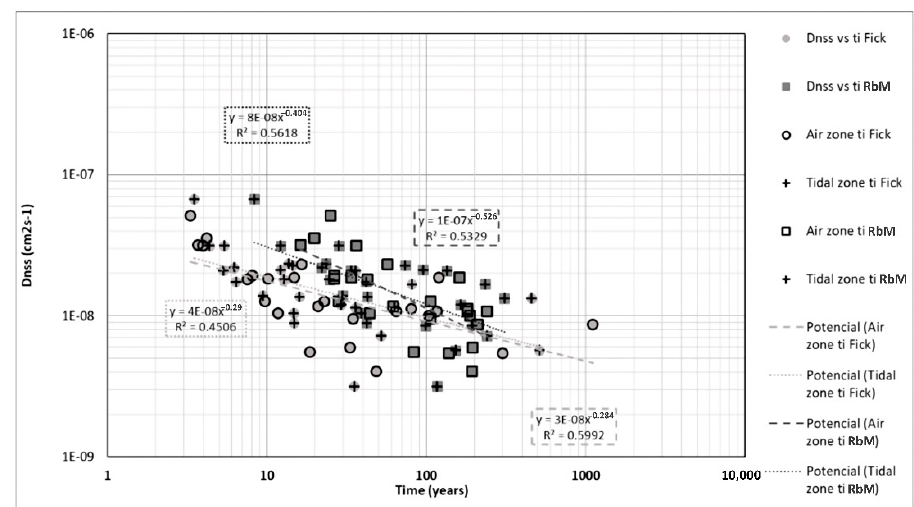
Figure 14. D nss vs. t i in both zones and models.